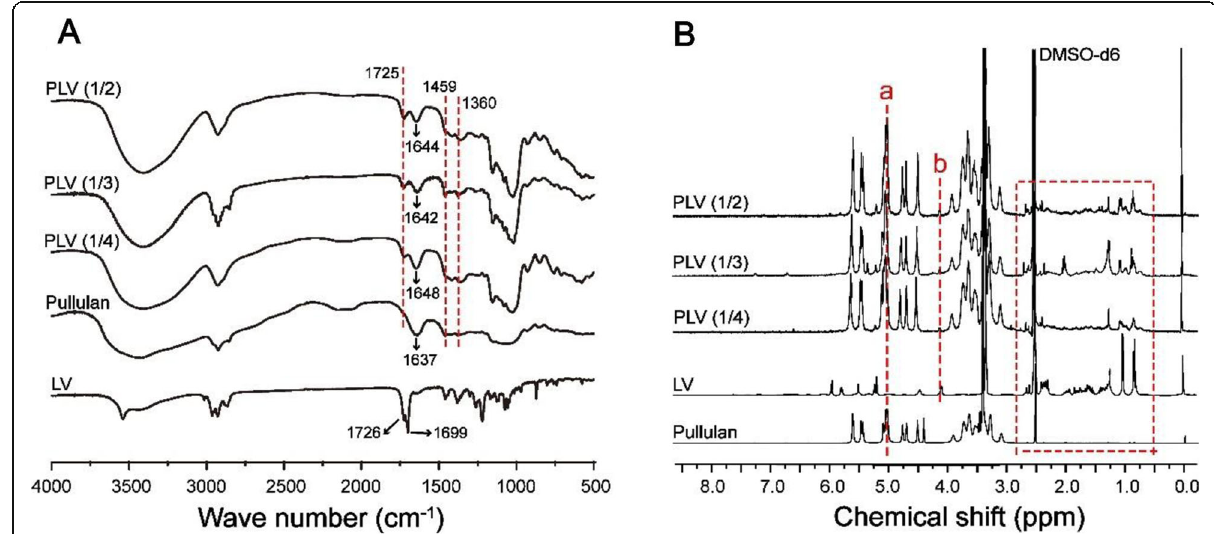
Fig. 3 Structural characterization of pullulan-lovastatin (PLV) conjugates. a FTIR spectra for pullulan, LV, PLV (1/2), PLV (1/3), and PLV (1/4), peaking at 1644, 1642, and 1648 cm − 1 as characteristic peaks of pullulan. The dotted lines at 1360, 1459, and 1725 cm − 1 show the bending vibration peaks of – CH 3 – and – CH 2 – for LV. b 1 H NMR spectra for pullulan, LV, PLV (1/2), PLV (1/3), and PLV (1/4)